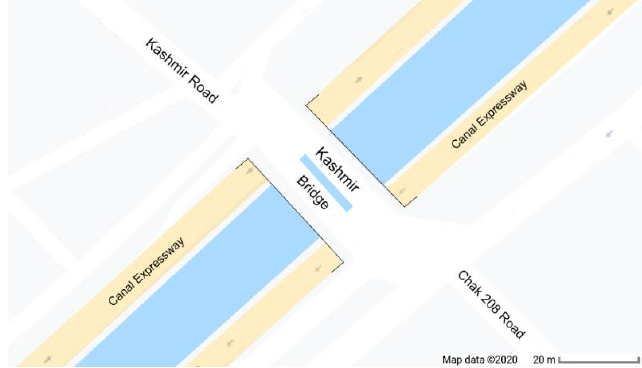
Figure 2: Projected map of Kashmir Underpass Project.